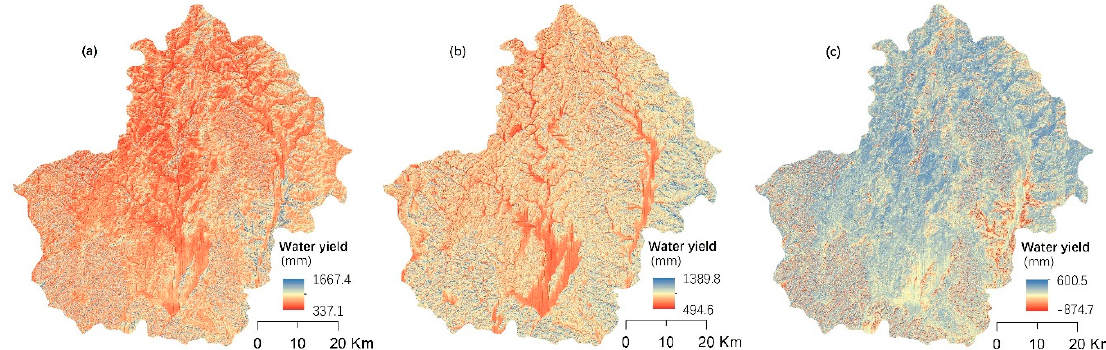
Figure 4. Spatial distribution of water yield and its change in Huanjiang County. ( a ) The distribution of water yield in 2005; ( b ) the distribution of water yield in 2015; ( c ) the changes of water yield from 2005 to 2015.